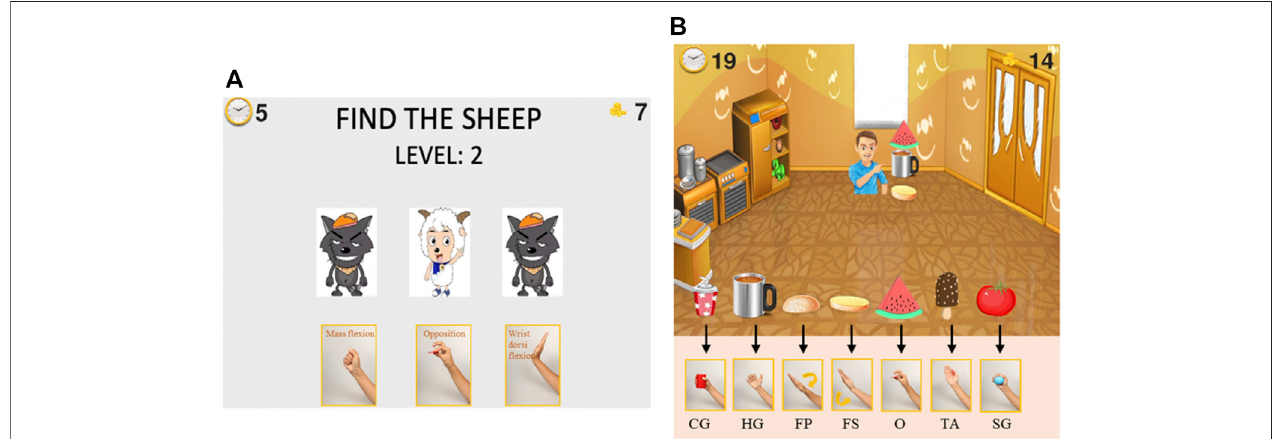
FIGURE 4 | Serious games for upper extremity motor function and cognitive function rehabilitation. Patients select the correct target in the serious game and perform the corresponding movement with their affected hand. (A) , “ Find the Sheep ” game: fi nd the location of the sheep card at the end of each round and perform corresponding movements. (B) , “ Best Salesman ” game: perform corresponding movement to provide customers with the food they need. The corresponding movements are only shown during training to stimulate cognitive